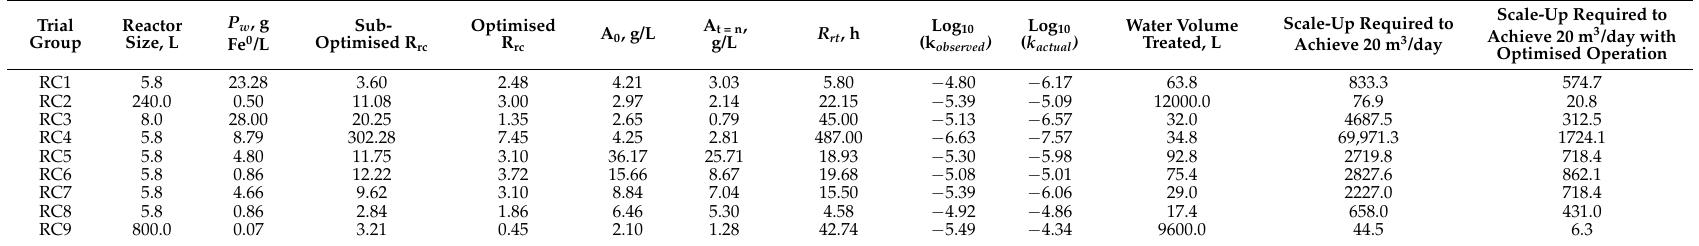
Table E1. Trial results associated with the operation of semi-closed Aquifer Treatment Zone with Recycle (Figure 20) . The recycle ratio, R rc = y (m 3 /day)/ m (m 3 /day). R rt = average residence time ( t d ) of the water in the reaction environment. Cartridge casing = MDPE. Each trial example used a different Type B catalysts (Table F1). A single catalyst charge was used in each trial group. Optimised operation assumes that t d is matched to the onset of B S . This reduces R rt (associated with each catalyst) into the range 3 to 12